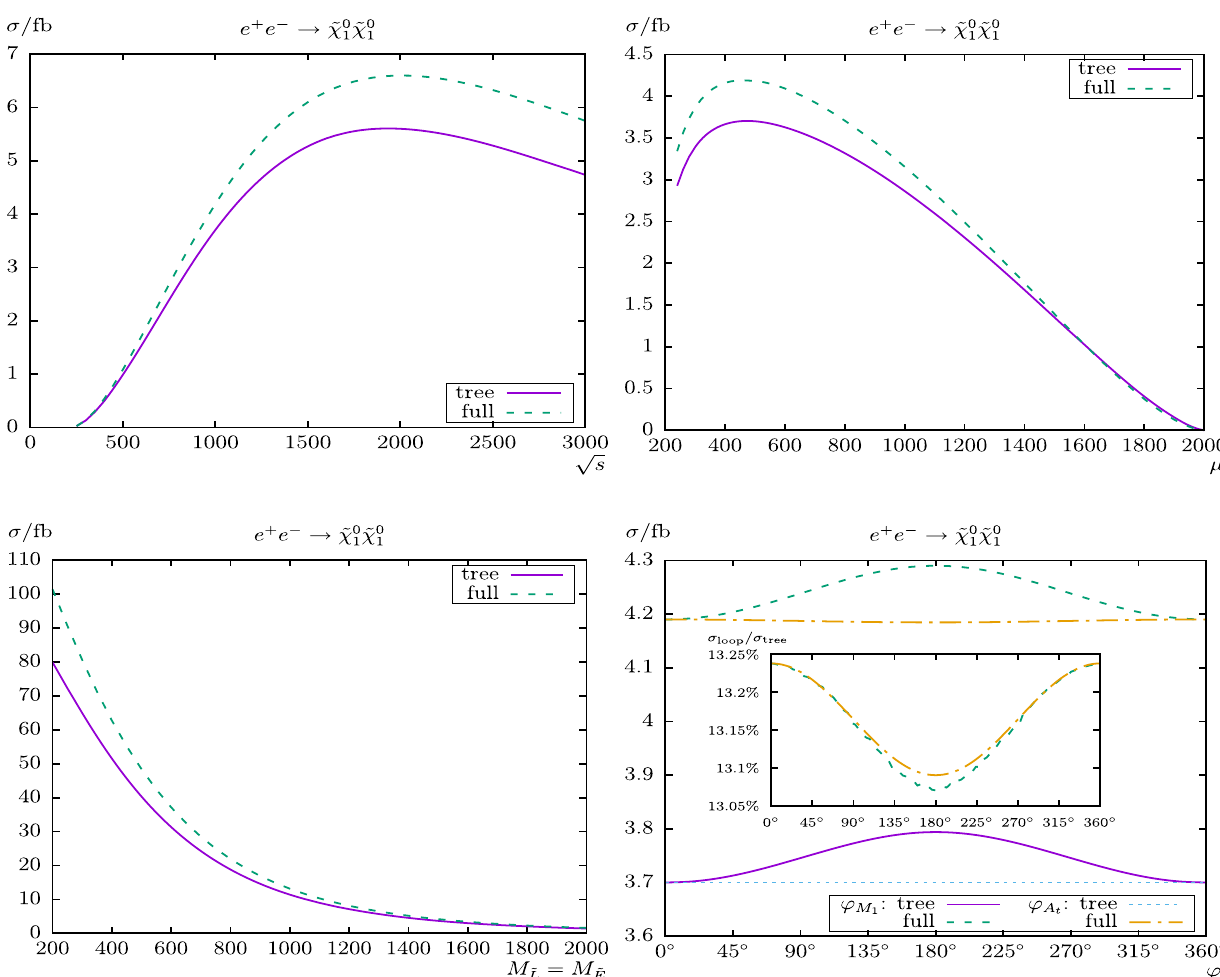
˜ χ 0 ) . Tree-level and full one-loop corrected cross sections are shown with parameters chosen according to S ; see Table 2. 1 1